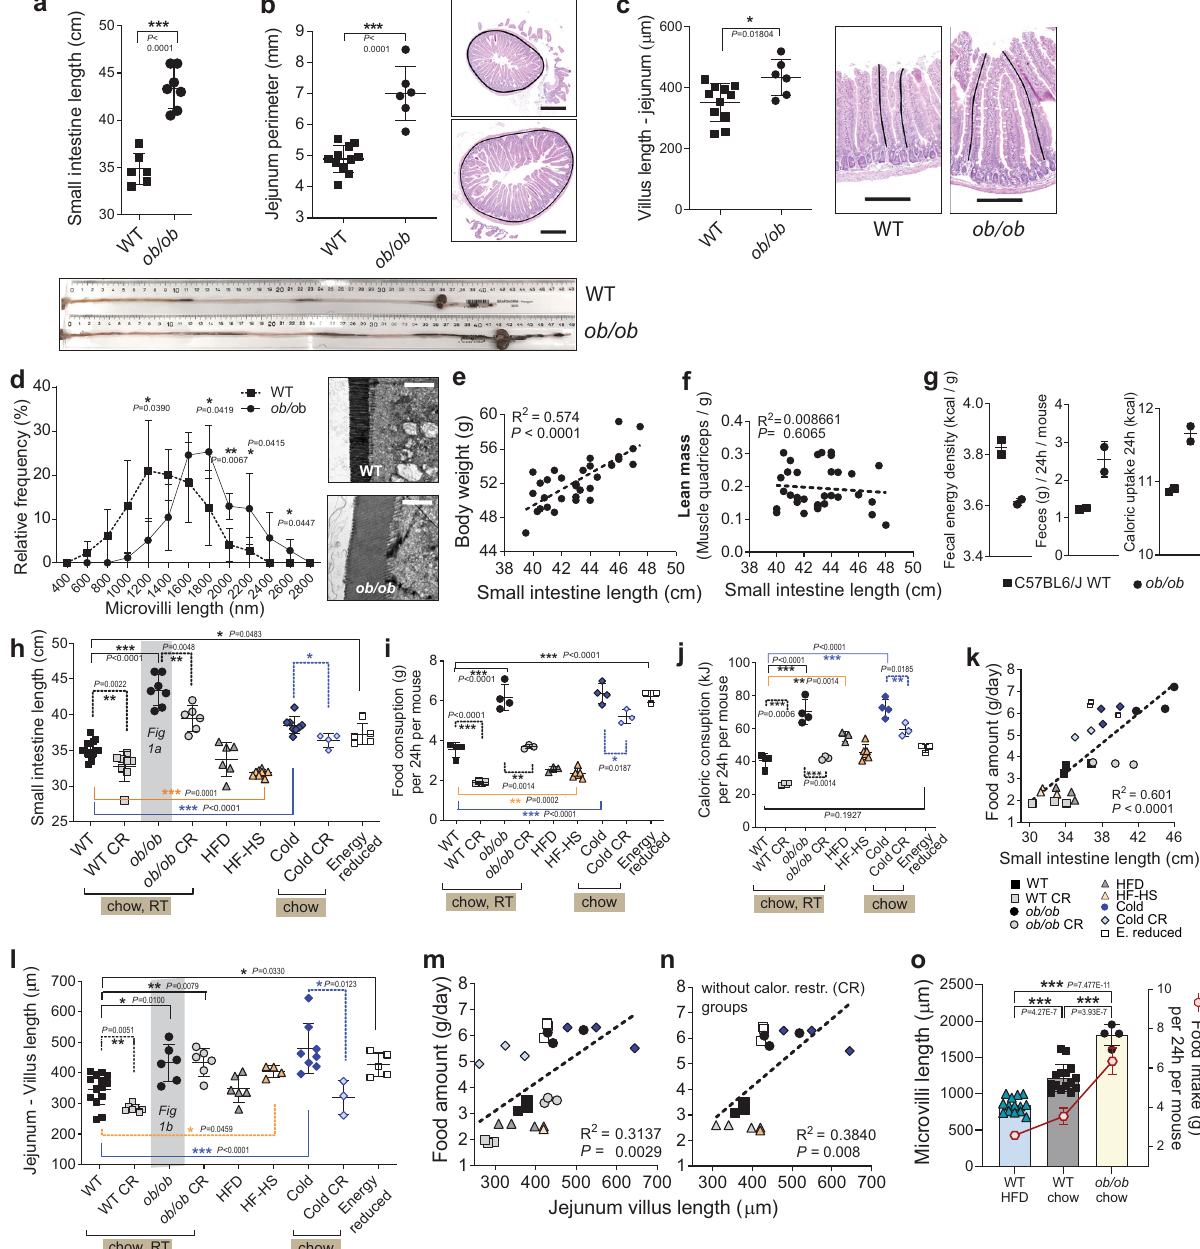
0.0080.3840 R 2 = P =